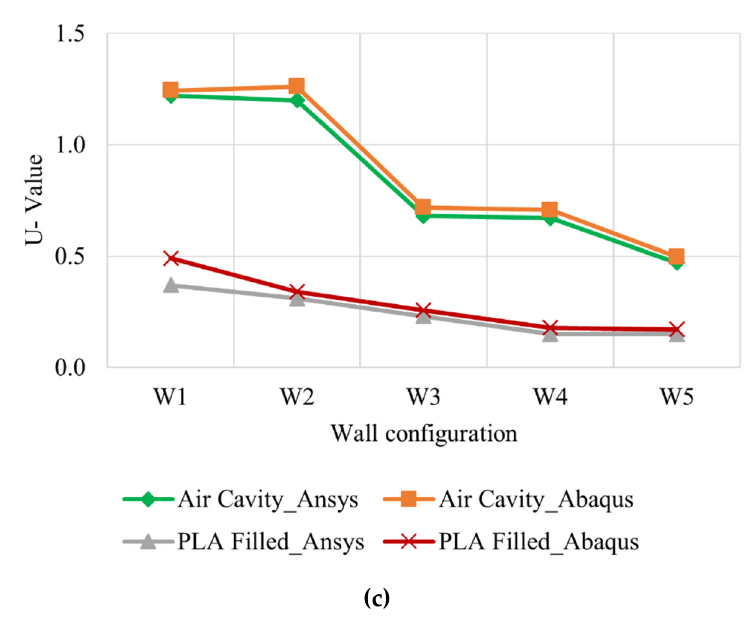
Figure 5. ( a ) Concrete Mix 1 U -value comparison; ( b ) concrete Mix 2 U -value comparison; ( c ) concrete Mix 3 U -value comparison.